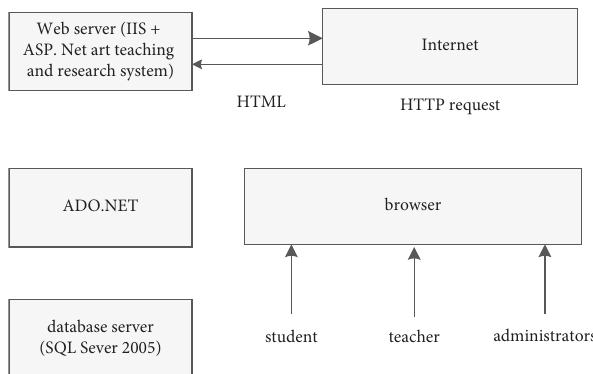
Figure 1: Structure design of the overall functional modules of the system.